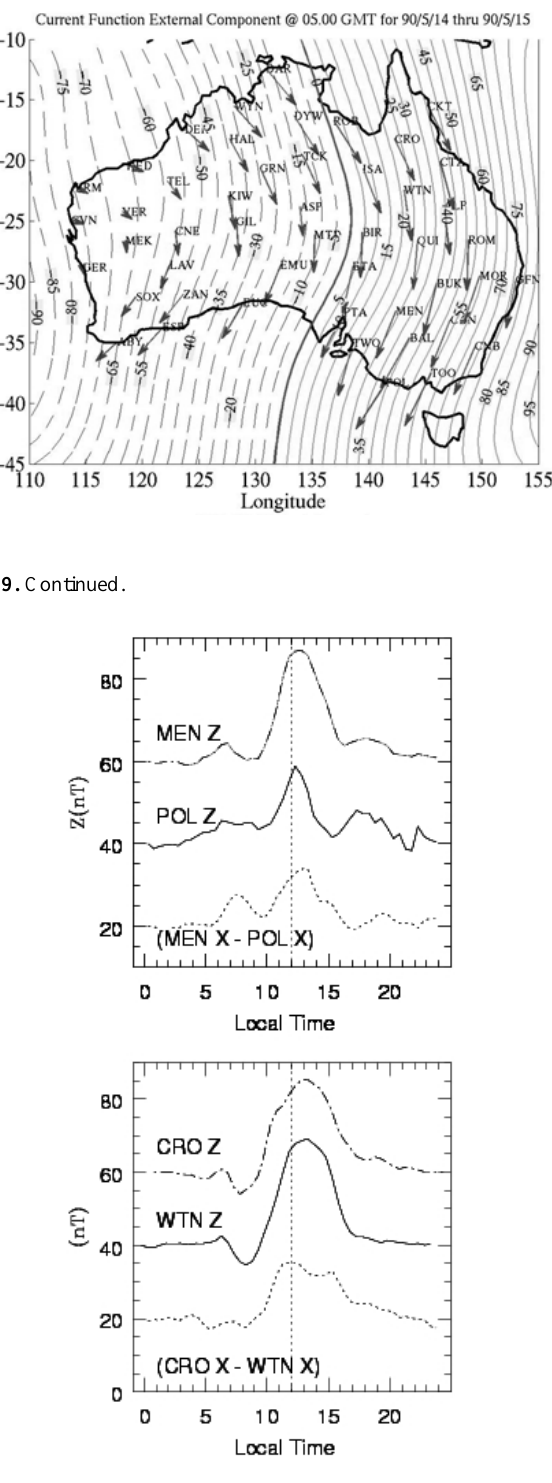
Fig. 10. Magnetic Z variations on 15 May 1990 together with the Fig 10. Magnetic Z variations on 15 May 1990 together with the differences between the X variations differences between the X variations at MEN and POL (top) and at at MEN and POL (top) and at CRO and WTN (bottom) – plotted every half hour. CRO and WTN (bottom) – plotted every half hour.